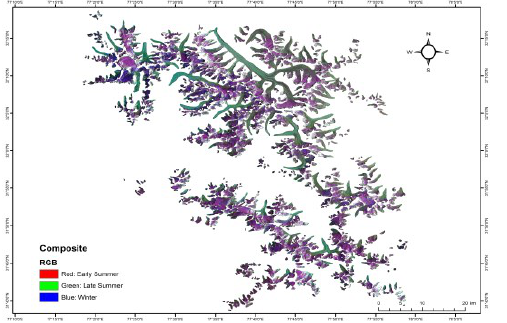
Figure 11. Glacier radar zones as seen in color composite